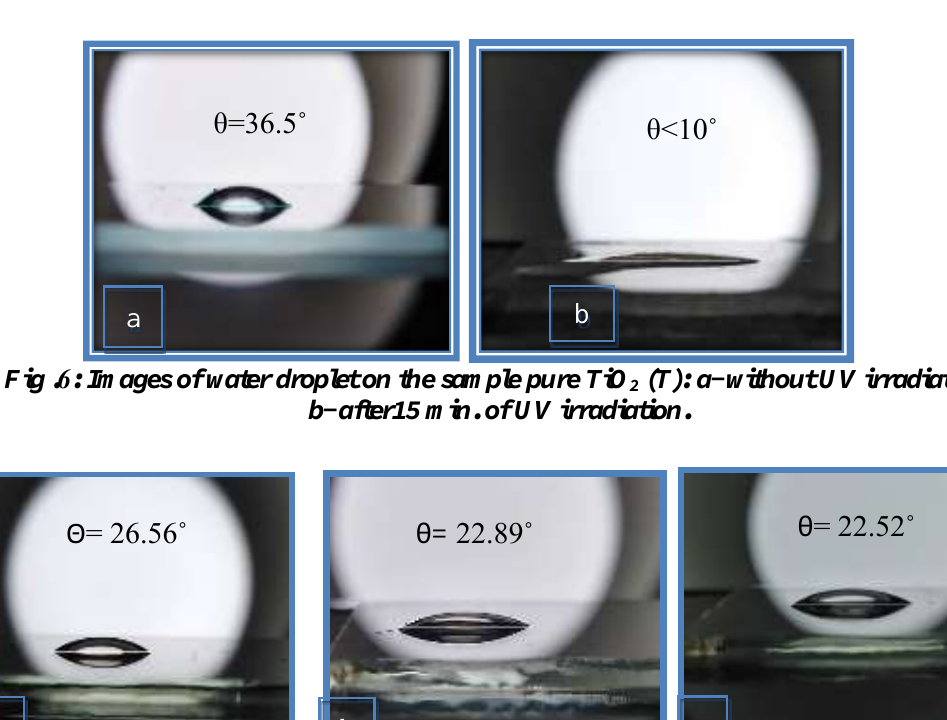
(Tm1): a-15min UV irradiation, 2